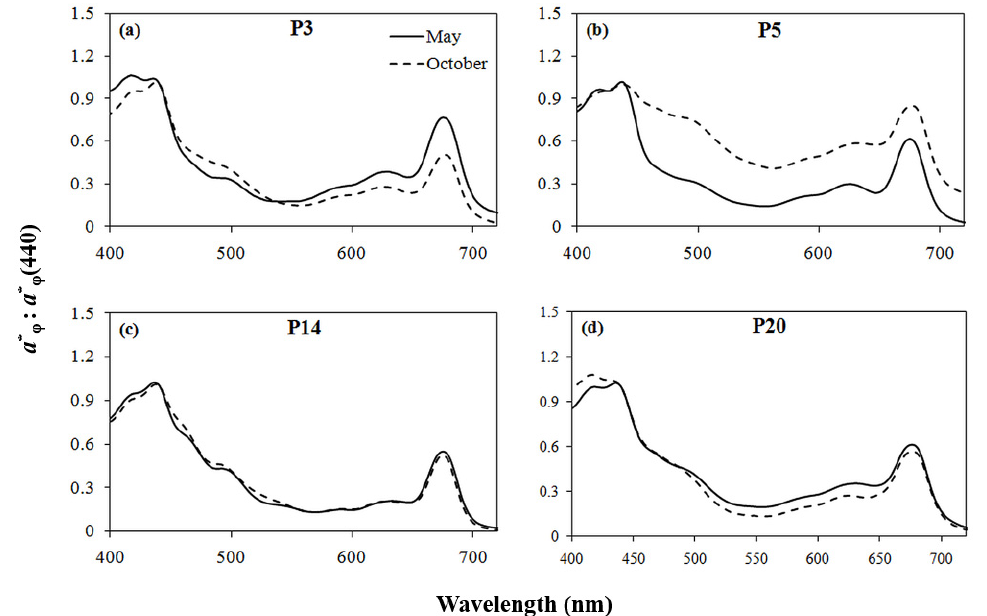
Figure 4. Normalized a * spectra for 440 nm collected at sampling stations: 3 (a), 5 (b), 14 (c) and 20 φ